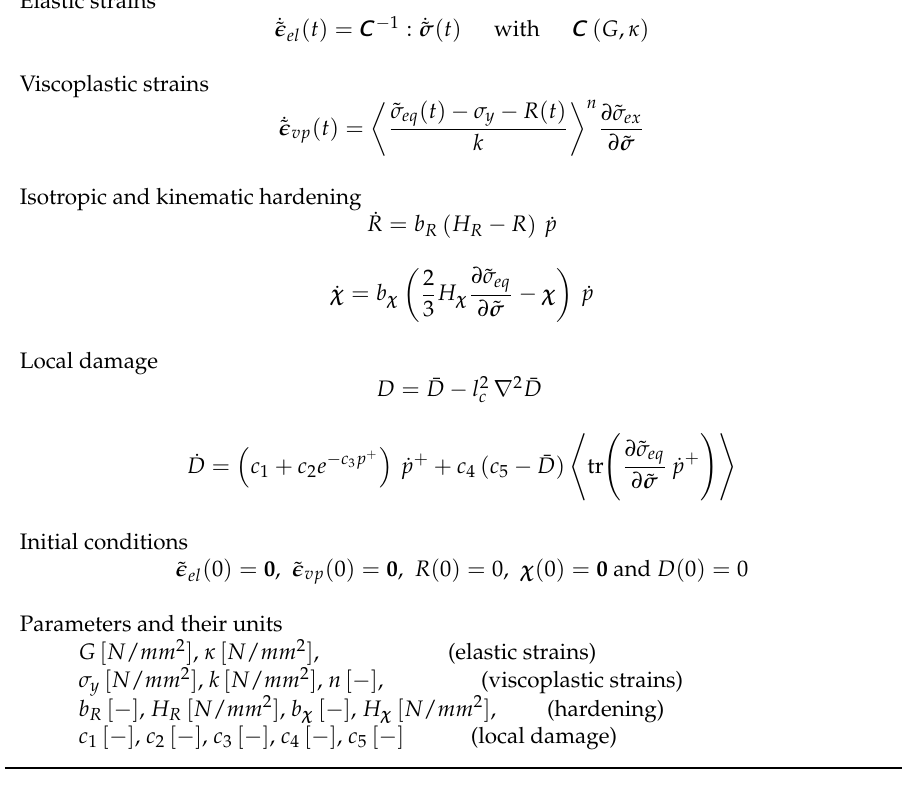
Table 1. Chaboche-type material with hardening and damage. Elastic